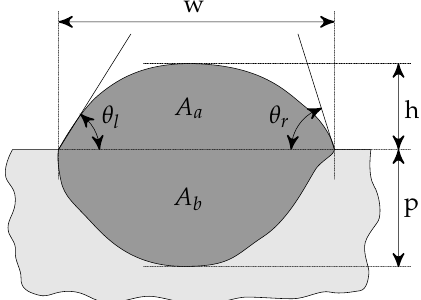
Figure 1. Schematic representation of DED-produced line bead